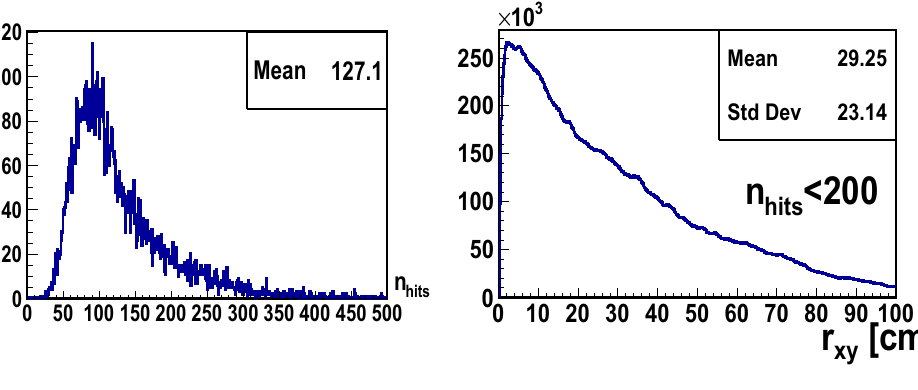
Figure 3. Number of DCH’s hits per event (on the left) and distance r x y = two consecutive DCH planes (on the right). The second spectrum is shown for the preselected events with DCH’s hit multiplicities under